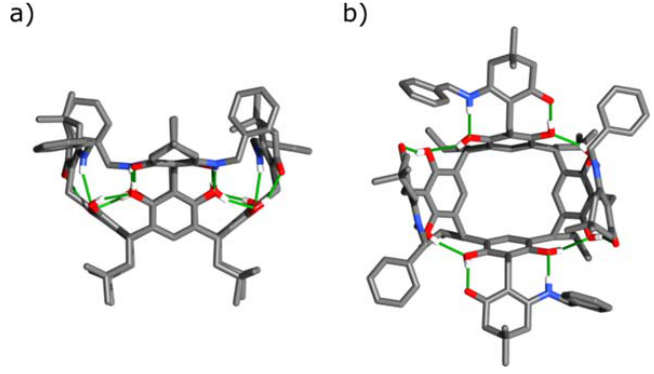
Figure 1. Crystallographic structure of 4 : ( a ) side view; ( b ) top view.